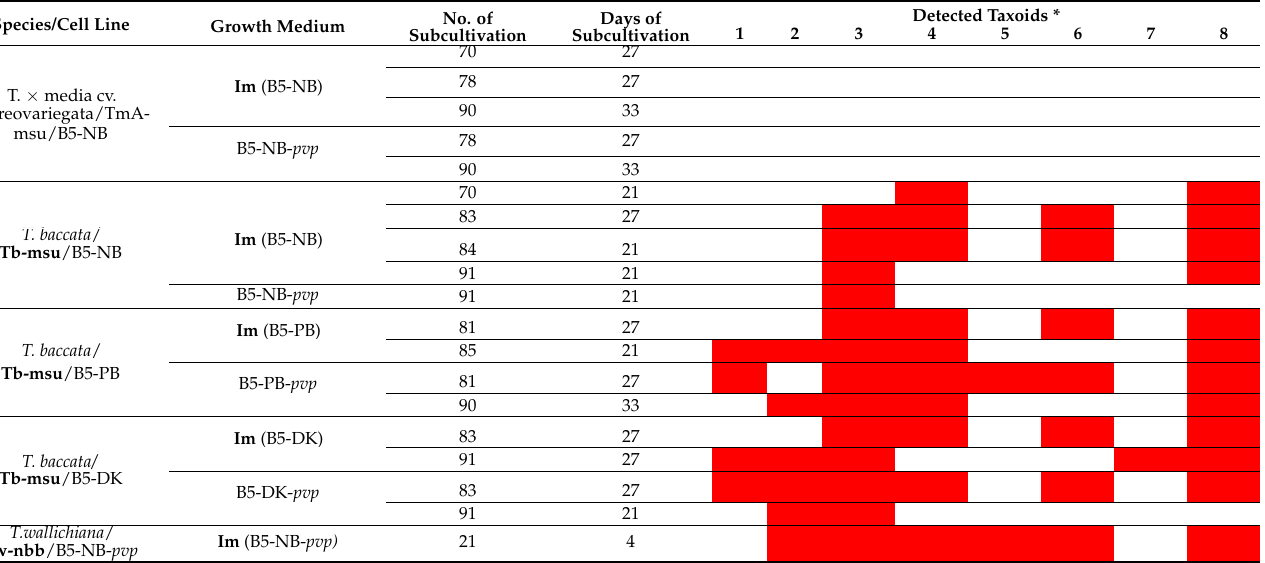
Table 6. Taxoids identified in suspension cell cultures of Taxus spp.